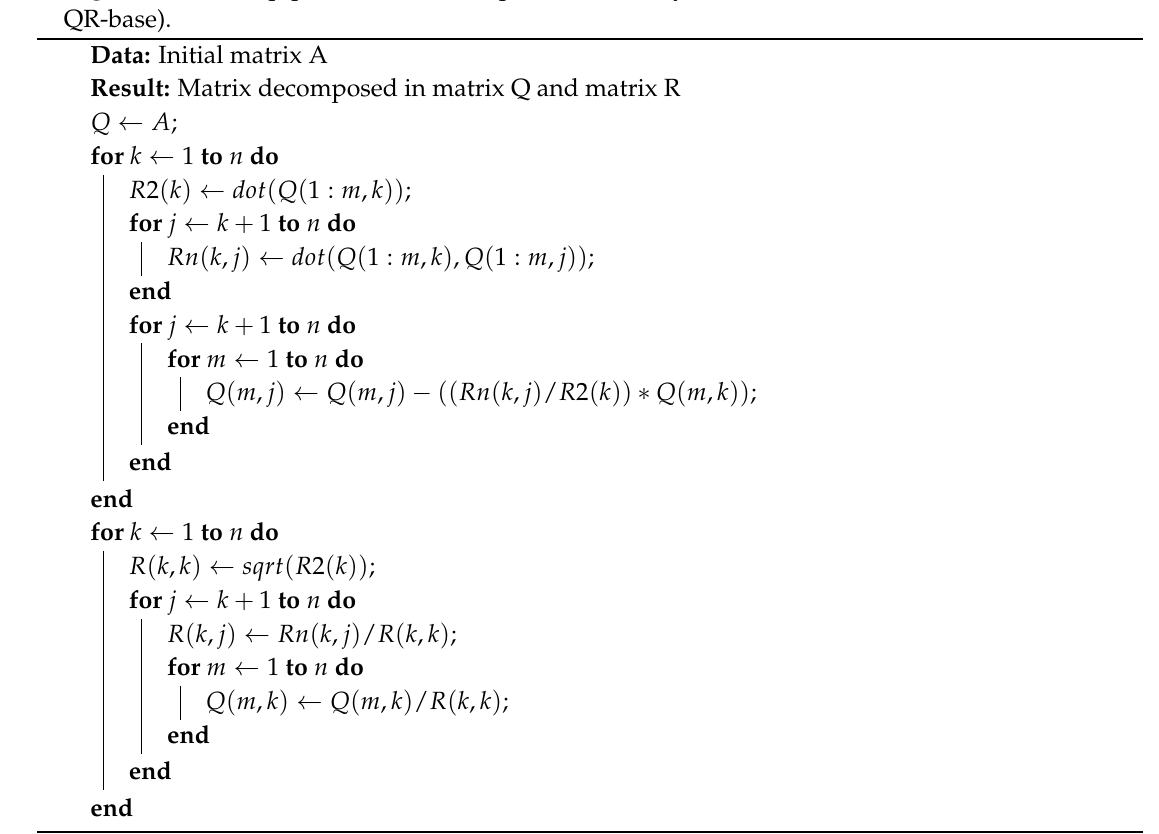
Algorithm 2: QR pipeline suitable implementation by Reference [2] (herein identified as